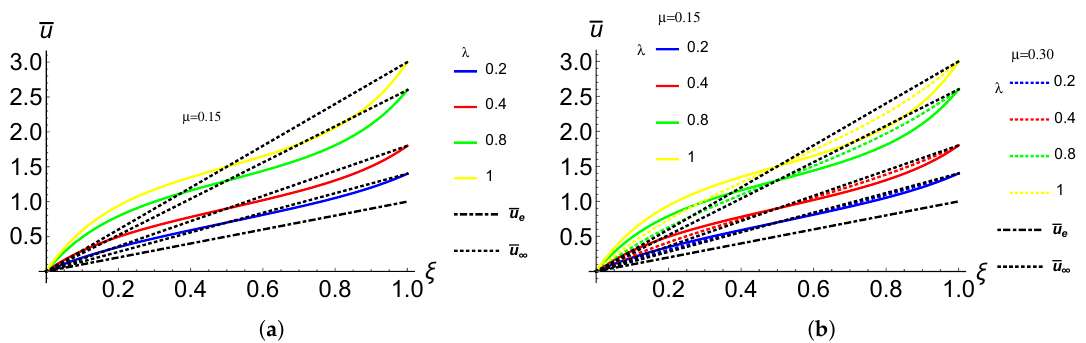
Figure 2. CF nano-rod with a concentrated load at the free end. Plot of the non-dimensional axial displacement ¯ u , limit non-dimensional axial displacement ¯ u ∞ (black dotted line) and local non-dimensional axial displacement ¯ u e (black dot dashed line) in terms of the nonlocal non-dimensional parameter λ in the set { 0.2,0.4,0.8,1.0 } and: ( a ) gradient non-dimensional parameter µ = 0.15; and ( b ) gradient non-dimensional parameter µ in the set { 0.15,0.30 } .